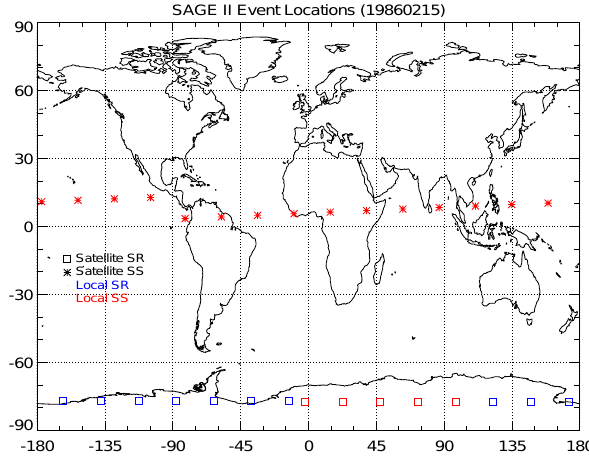
Figure 2. Locations of SAGE II events for a single day. Ground-track swaths are separated by satellite event type. While local event types are typically uniform within a swath, they can occasionally be different at high latitudes.